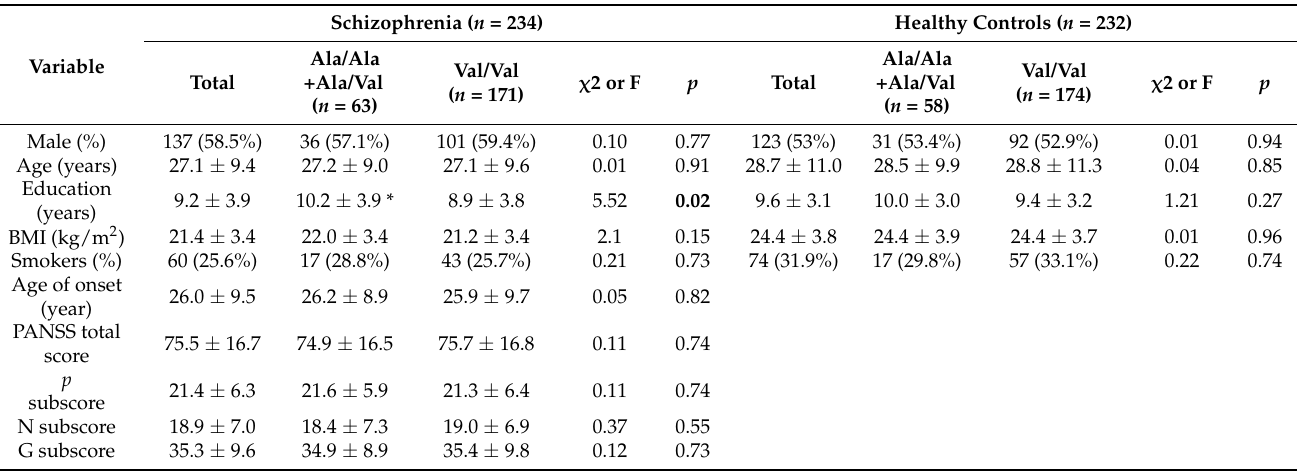
Table 1. Demographics and clinical characteristics in first-episode patients and healthy controls grouped by MnSOD Val-9Ala